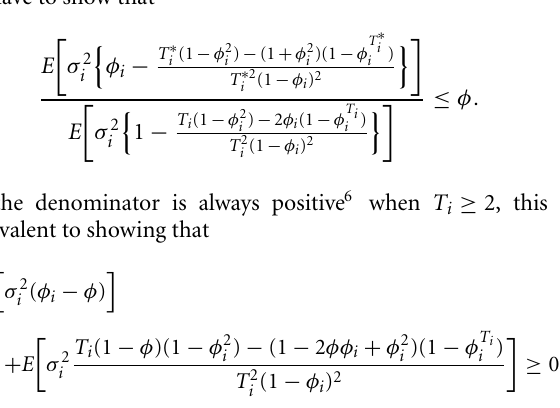
FIGURE A1 | Numerator of expectation, [that is, y = T (1 − φ )(1 − φ 2 )(1 − φ T )] plotted against φ i , for T = 40 and different (1 − 2 φφ i + φ 2 i i values of φ (i.e., average φ i ). Note that only for φ = 0 . 95 the